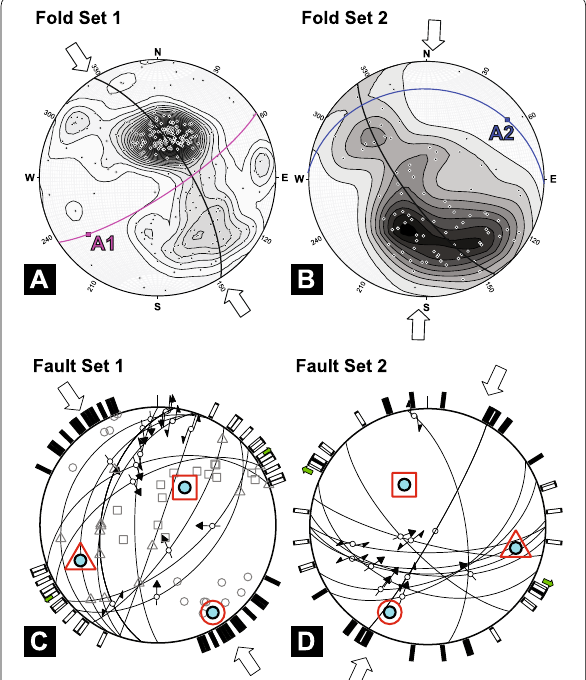
Fig. 6 a , b π-diagram of the Set 1 and Set 2 of folds with the calculated axial surfaces and axes (A1 and A2, respectively); c , d fault slip data inversion, after unfolding for faults of Set1 and Set2,